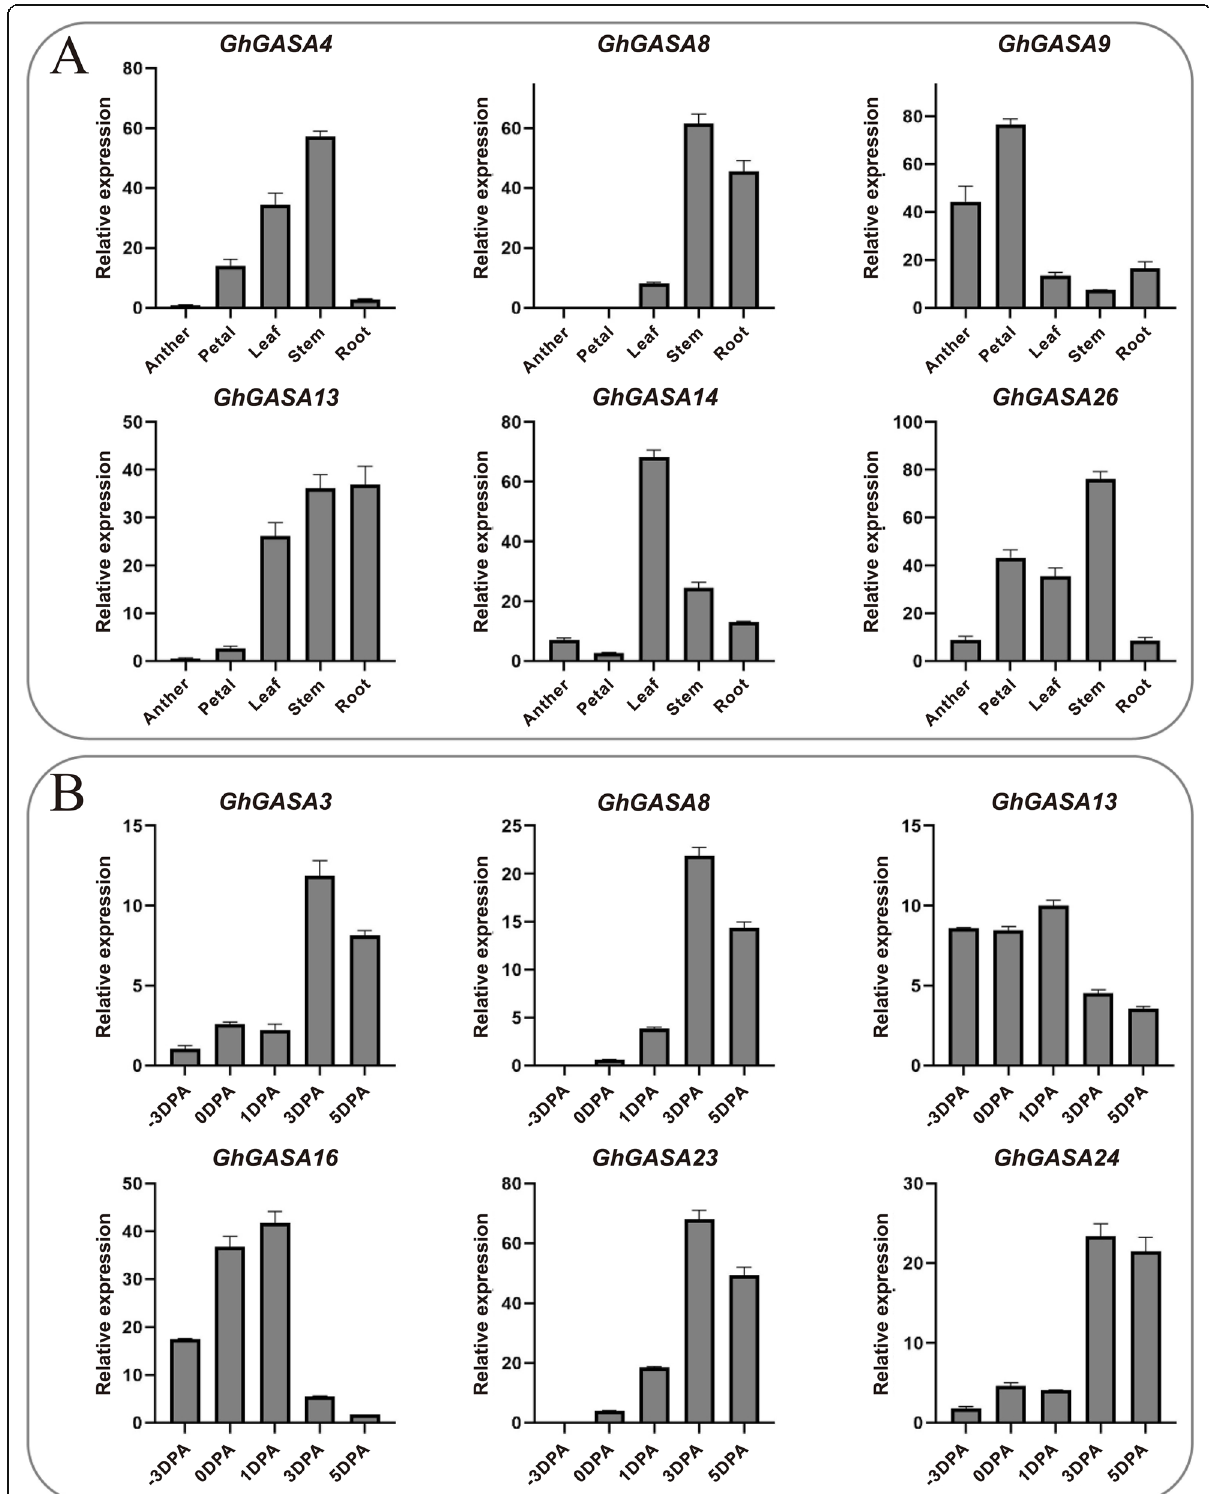
Fig. 4 The expression profiles of 38 GhGASA genes by RT-qPCR . a Expression levels of GhGASA4, GhGASA8, GhGASA9, GhGASA13, GhGASA14, and GhGASA26 in anther, petal, leaf, stem, and root. b Expression levels of GhGASA3, GhGASA8, GhGASA13, GhGASA16, GhGASA23, and GhGASA24 in − 3, 0, 1, 3, and 5 DPA